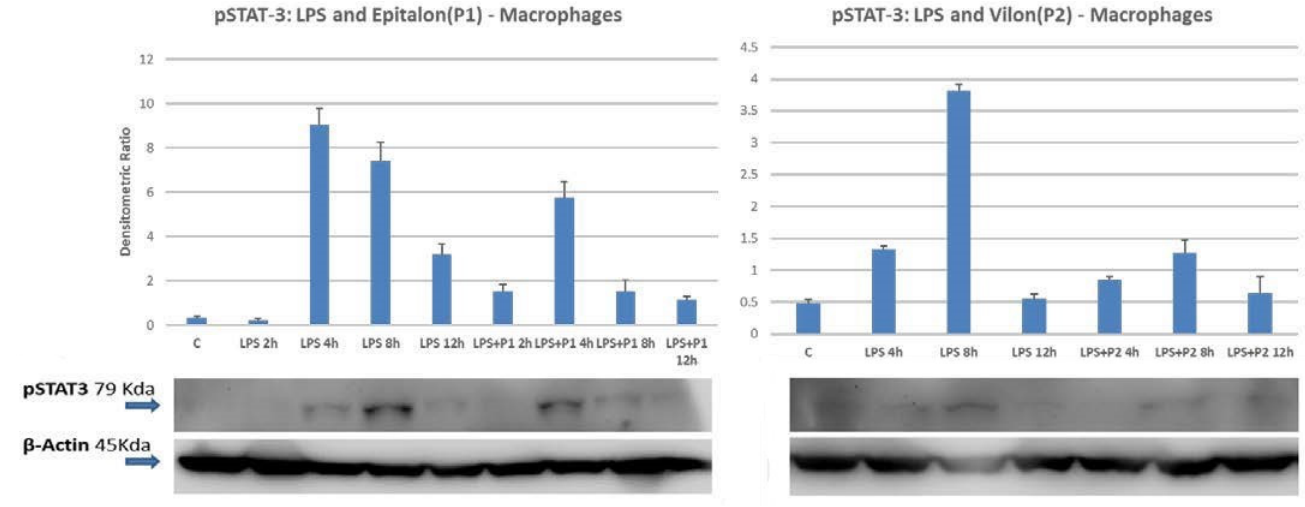
Figure 4. pSTAT3 activation upon LPS and LPS + bio-peptides. Densitometric analysis was per- formed normalizing band intensity to β -actin expression. Bar graphs show the mean values of three independent experiments.